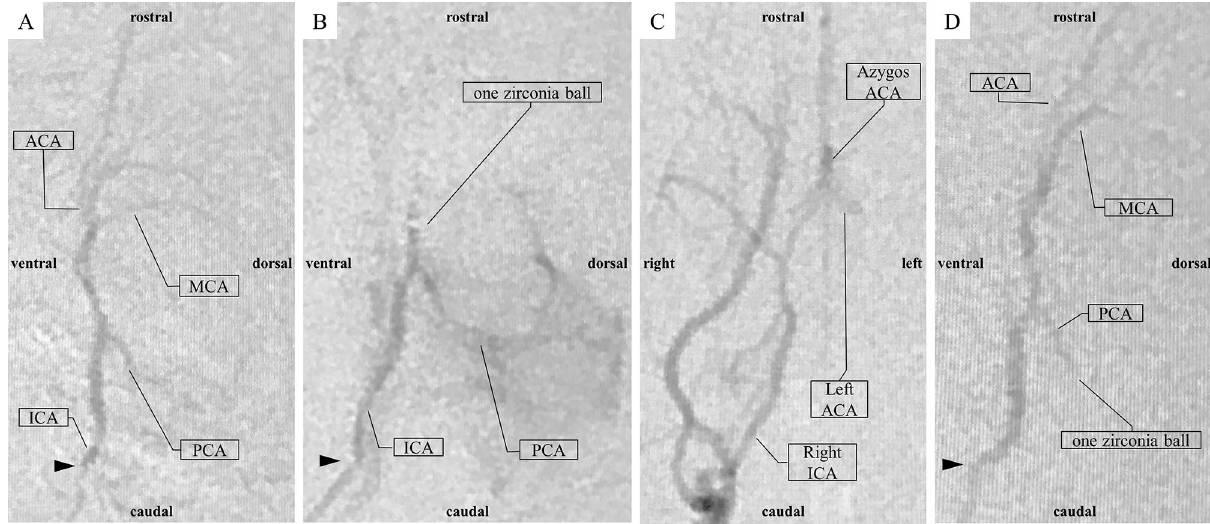
Figure 3. Angiography and embolization. The arrowhead shows the tip of the microcatheter. ( A ) Left ICA angiography (LAO angle = 80°). ( B ) The left ACA and MCA bifurcation was selectively embolized by one zirconia ball (LAO angle = 80°). The PCA was better visualized than before embolization. ( C ) Right CCA angiography (LAO angle = 0°). The left ACA retrograde flow is maintained through the right ACA. ( D ) The left PCA was accidentally failure embolized by one zirconia ball (LAO angle = 80°). ACA anterior cerebral artery, ICA internal carotid artery, LAO left anterior oblique, MCA middle cerebral artery, PCA posterior cerebral artery.